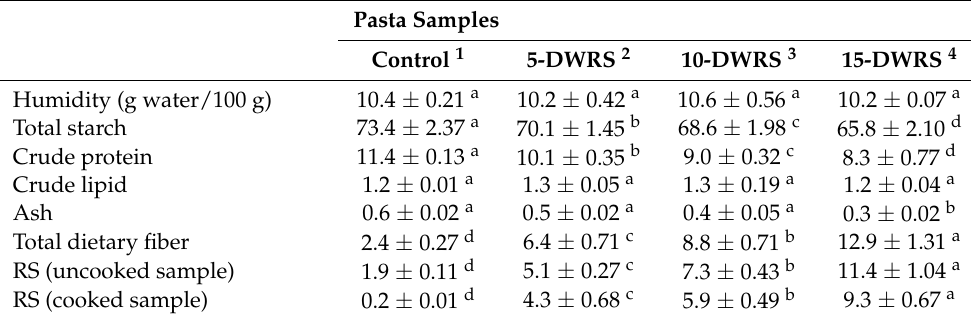
Table 1. Chemical composition (g/100 g dry matter) of semolina spaghetti containing resistant starch (RS) from debranched waxy rice starch (DWRS). Pasta Samples Control 1 5-DWRS 2 Humidity (g water/100 g)